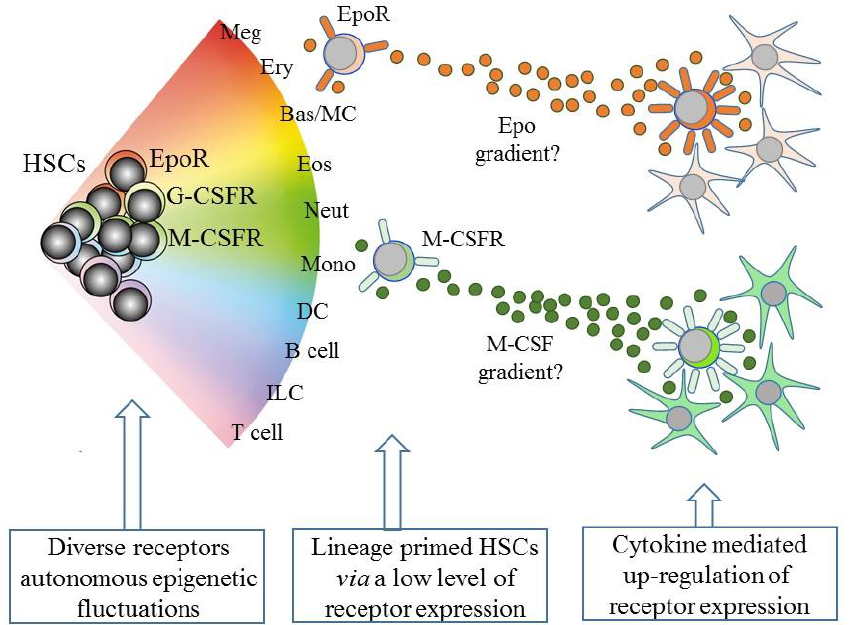
Figure 2. A continuum model of hematopoiesis and the instructive role of cytokines. Hematopoietic stem cells (HSCs) “choose” a lineage from a continuum of the variety of options and are a mixture of cells with different lineage signatures, shown by the different colors. HSC sub-populations express mRNA for the receptor for erythropoietin (EpoR) and the receptors for macrophage colony- stimulating factor (M-CSFR) and granulocyte colony-stimulating factor (G-CSFR) at low levels. Their cytokines can instruct erythroid, monocyte, and neutrophil fates, respectively, and may also provide a chemotactic gradient to attract cells to a niche. Macrophage-colony stimulating factor (M-CSF) and granulocyte-colony stimulating factor (see text) positively auto-regulate receptor expression. Meg, megakaryocyte; Ery, erythrocyte; Bas/MC, basophil/mast cell; Eos, eosinophil; Neut, neutrophil; Mon, monocyte; DC, dendritic cell; ILC, innate lymphoid cell.